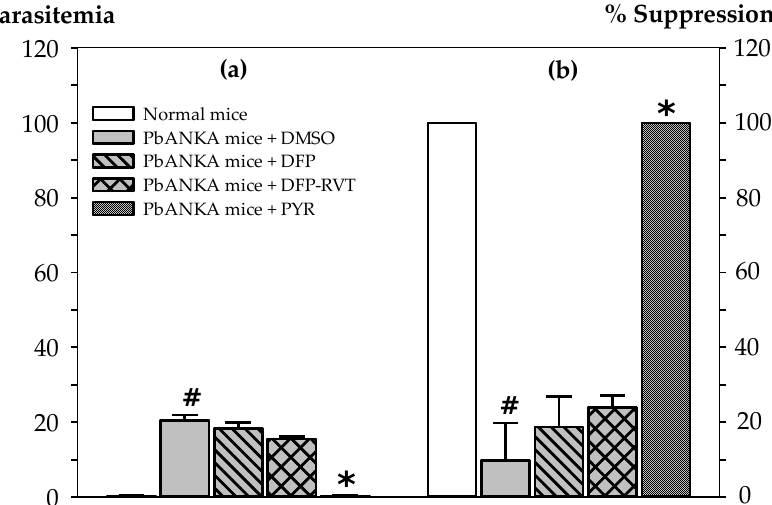
Figure 2. Suppressive activity of DFP, DFP-RVT and PYR against P. berghei (ANKA strain) infection in mice. Male ICR mice (n = 3 each) were infected intraperitoneally with PRBC suspension (1 × 107 cells/mL with 5–20% parasitemia), then orally administered with 60% DMSO, PYR (2 mg/kg BW), DFP (50 mg/kg BW) and DFP-RVT (50 mg/kg BW) every day. The BW of the subjects were recorded after 4 d and they were finally euthanized. Blood was collected from the hearts of the subjects and the percentage of PRBC was determined and expressed as either % parasitemia ( a ) or % suppression ( b ). Data are expressed as mean ± SEM values (n = 3). # p < 0.05 when compared to normal mice; * p < 0.05 when compared to PbANKA mice treated with DMSO.